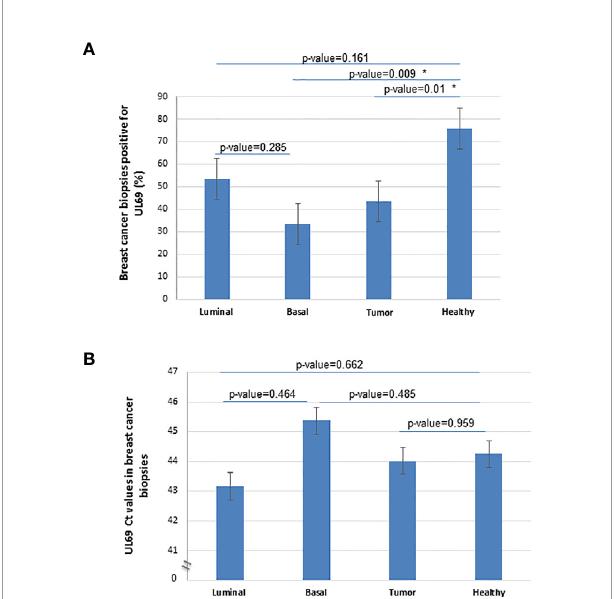
FIGURE 6 | Detection of UL69 DNA in human breast cancer biopsies. (A) Percentage of UL69 -positive samples (Ct<50) in breast tumor biopsies (n=30), including luminal (n=15) and basal-like (n=15) tumors, and in adjacent healthy paired breast tissue (n=29) using UL69 quantitative PCR measurement. (B) Quanti fi cation of HCMV UL69 DNA in breast tumor biopsies (n=30) compared to healthy adjacent paired breast tissue (n=29), and in patients with basal-like breast cancer (n=15) compared to patients with luminal breast cancer (n=15), as measured by quantitative PCR UL69 Ct value. * A statistically signi fi cant difference at p -value < 0.05. Histogram data are represented as mean ± SD of two independent